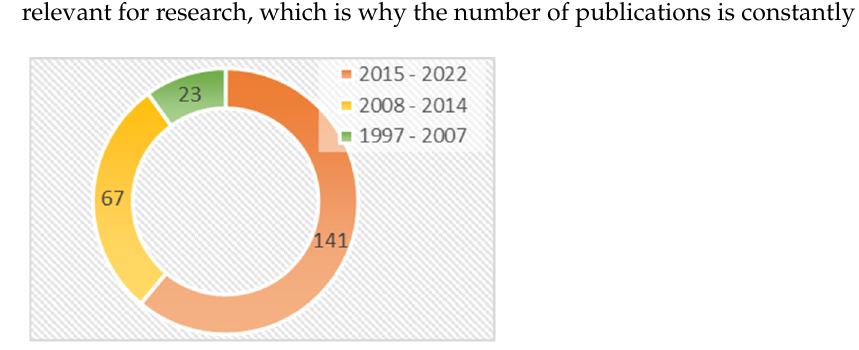
Figure 5. Graphic representation of scienti fi c articles published from 1997 to 2022 and collected from WOS with the PFP as a general subject of study.